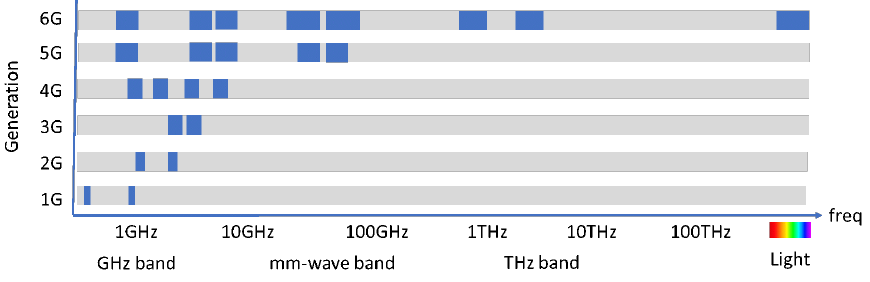
Figure 6. Spectrum usage throughout the past, present, and future mobile generations